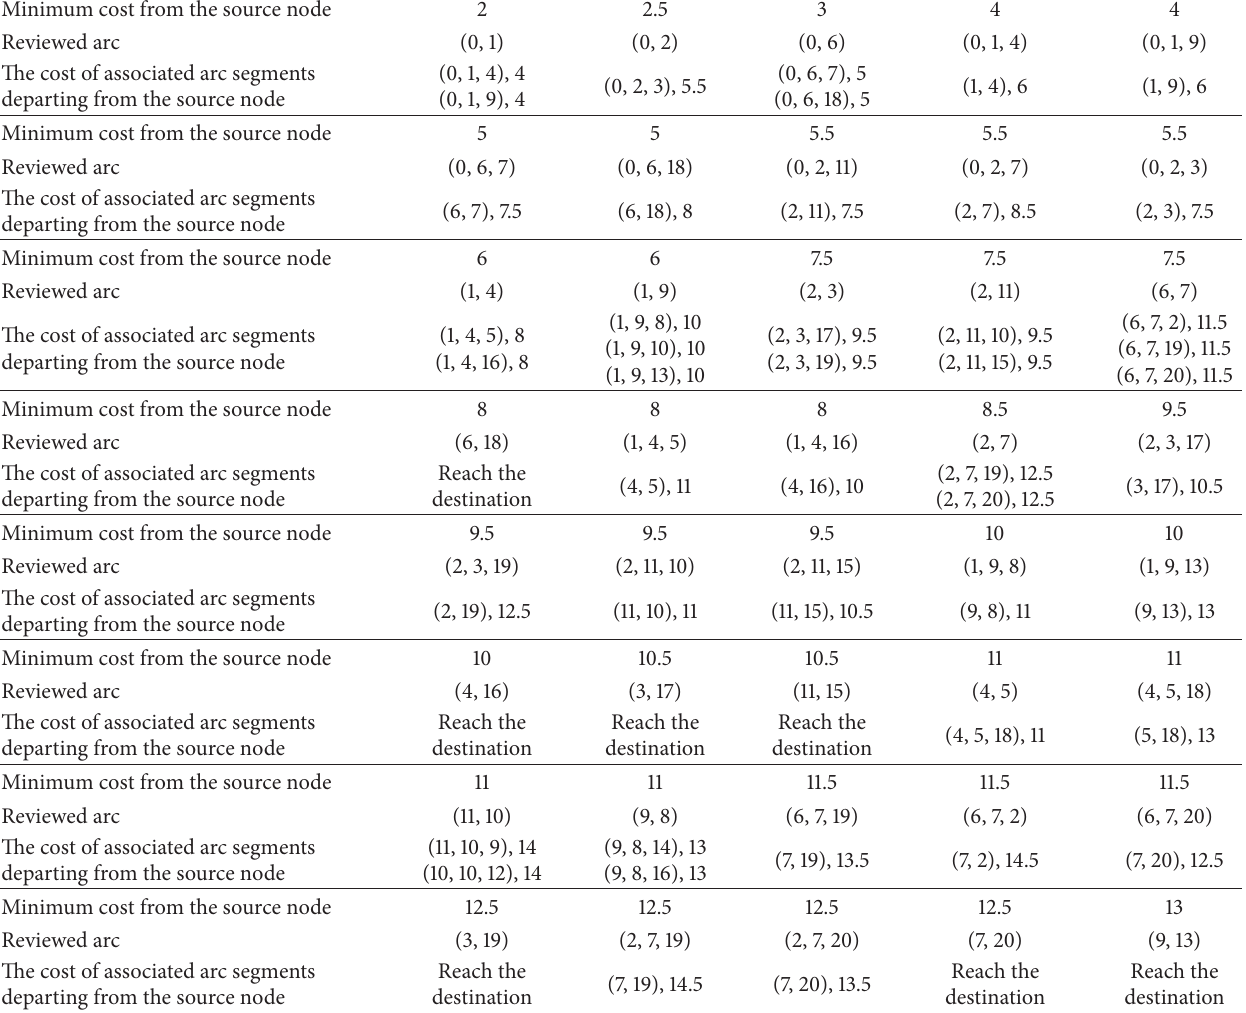
Table 7: Optimal routes of one-to-many emergency on MC-MFM.